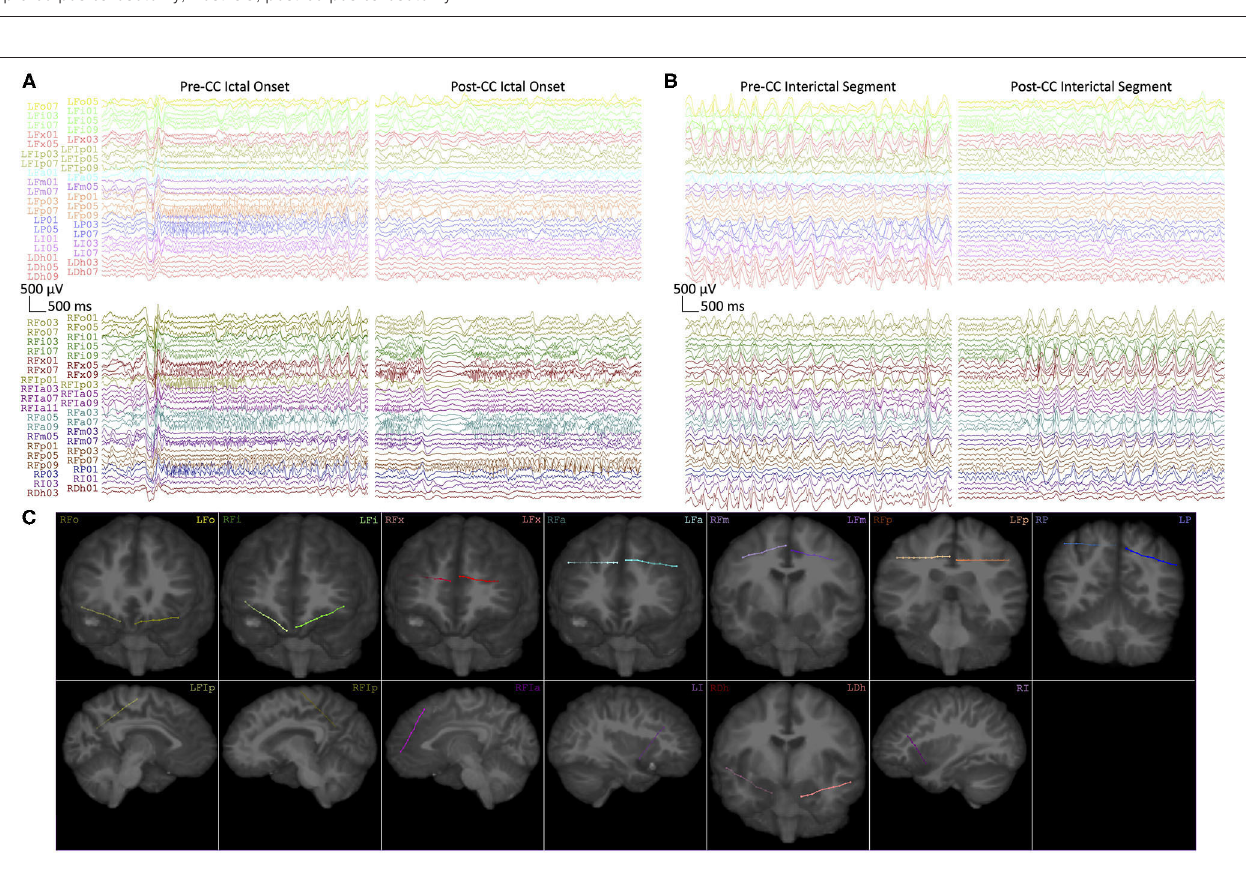
FIGURE 4 | (A) Representative intracranial EEG of seizure onsets from Subject 1 before (Pre-CC) and after (Post-CC) corpus callosotomy (seizures 1 and 6, respectively). Each electrode array is represented by a different color, with left-sided arrays on top and right-sided arrays on the bottom. The pre-CC seizure shows bilaterally-synchronous onset, whereas the post-CC seizure exhibits onset and evolution on the right. (B) Representative segments of interictal EEG from Subject 1 before (Pre-CC) and after (Post-CC) corpus callosotomy, channels represented as in (A) . The pre-CC EEG exhibits widely-distributed bilateral pathology, whereas the post-CC EEG shows lateralization of interictal pathology to the right. All segments referenced to a common average and filtered between 1 and 59Hz with a 8th-order zero-phase Butterworth filter. (C) Reconstructions of the implantation locations of all of the electrode arrays in (A,B) , with deeper channels represented by lower numbers, the terminal contact being numbered “1.” Contacts outside of the plane of the image are represented by proportionally-decreased alpha opacity.